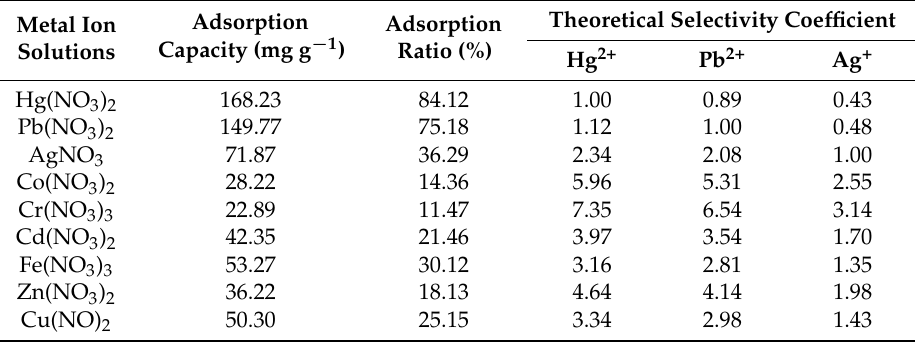
Table 2. Adsorption capacity and adsorption ratio of nine metal ions at an initial metal concentration of 200 mg L − 1 and an adsorption temperature of 25 ◦ C for a contact time of 24 h with a PBT sorbent dosage of 1.0 g L − 1 .